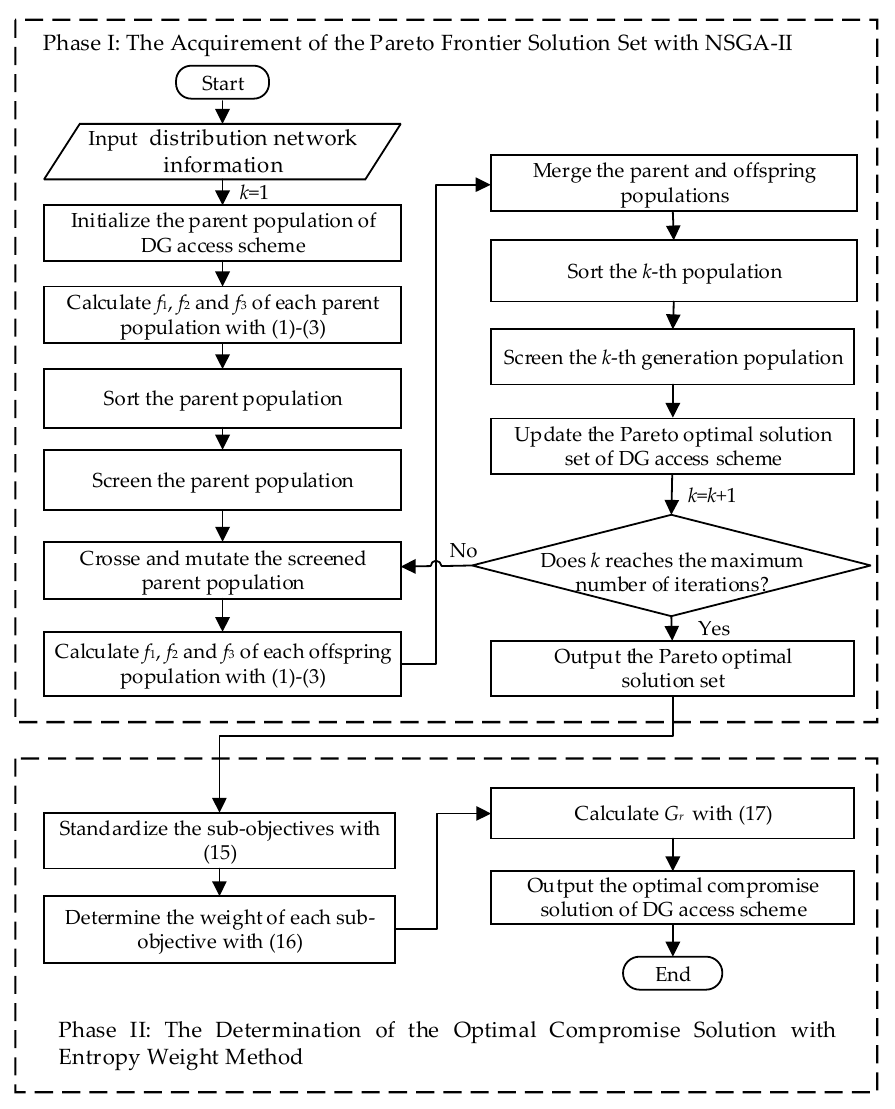
Figure 1. Flowchart of the proposed evaluation model for the acceptance capacity of DG in distri- bution networks.